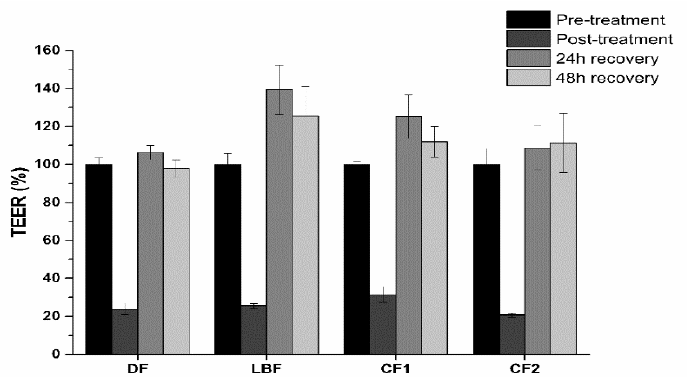
Figure 12. TEER values recorded before the treatment (Pre-treatment), after exposure to digested fluids (DF) or formulations (Post-treatment) at the bioaccessible concentrations, and upon 24 and 48 h recovery. Values are expressed as percentage of the pre-treatment TEER value ( n = 3).